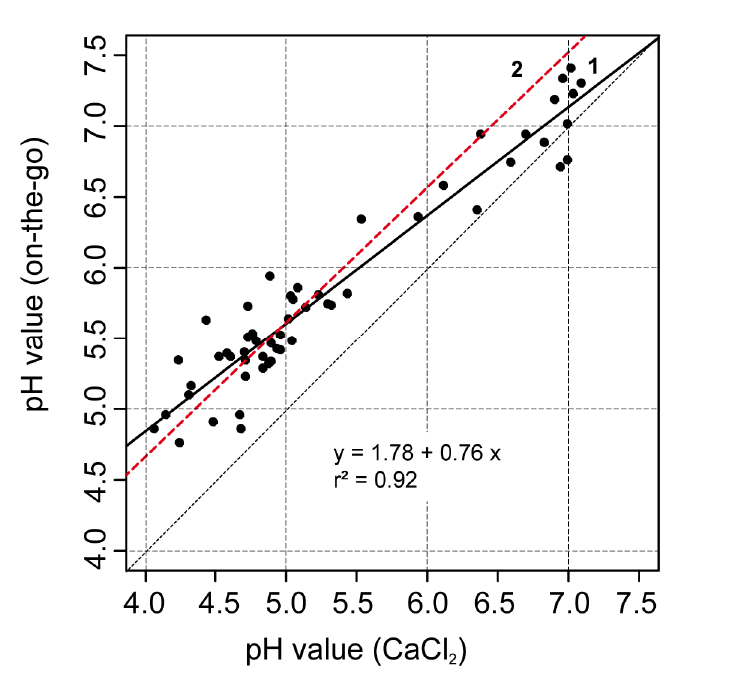
Figure 7. Scatter plot of on-the-go measurements and lab pH values with the corresponding regression model (black line, 1) from transects shown in Figure 6. The black dotted line shows the 1:1 relationship and the red dotted line (2) is the regression model of